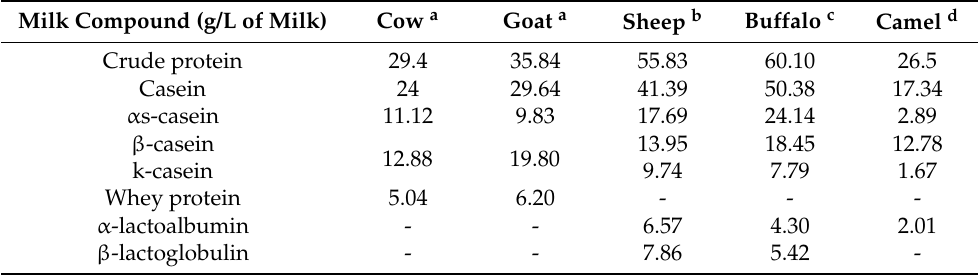
Table 2. Major milk proteins of several highly consumed animal